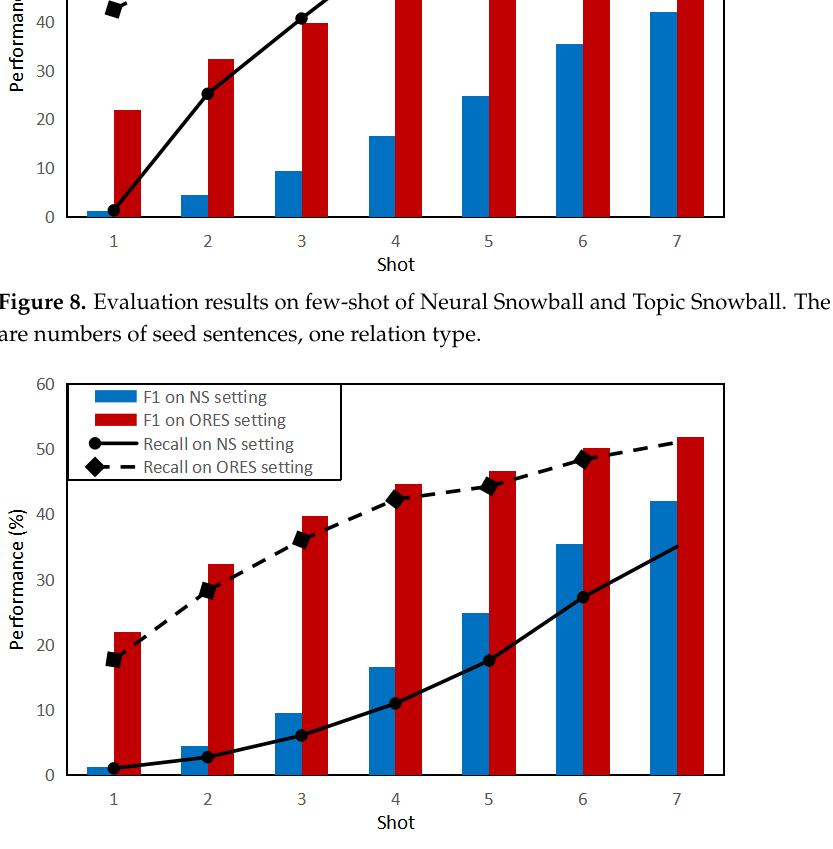
Figure 9. Demonstrates the development of evaluation results as the number of shots